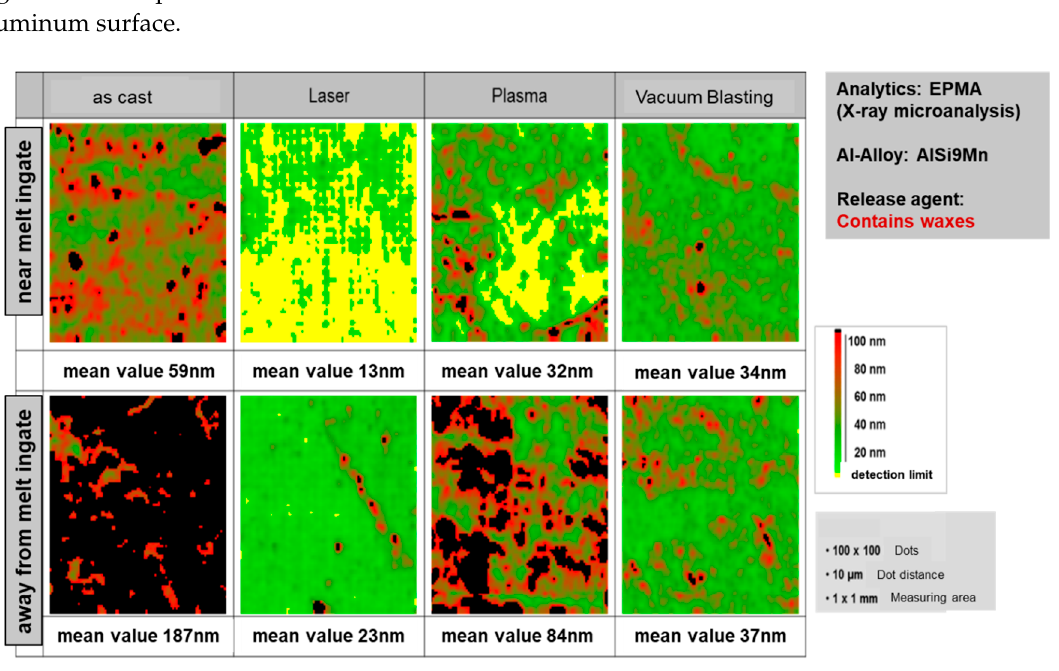
Figure 7. EPMA (X-ray microanalysis; carbon content) of the aluminum die-cast surface after various pre-treatments. Adapted from [164].